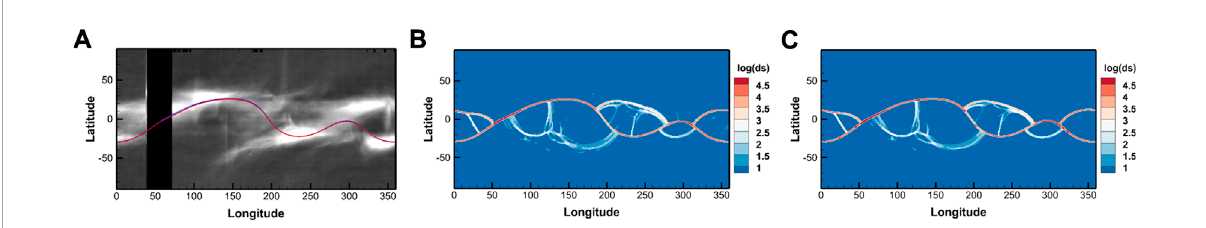
FIGURE 7 Synoptic map at 2 . 5 R s : (A) the pB at the east limb observed by SOHO/LASCO C2; (B) log (ds) obtained by SHE solver; (C) log (ds) obtained by DDG-PFSS solver. The red line in (A) denotes the magnetic neutral line ( B r = 0 ) from the SHE solver, while the blue line represents the magnetic neutral line from the DDG-PFSS solver.